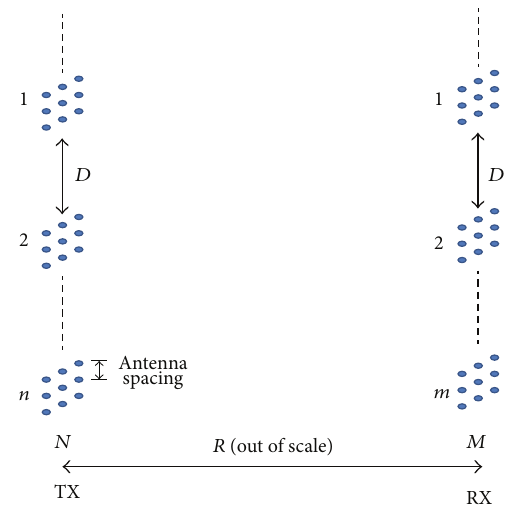
Figure 1: N × M MIMO system geometry. Each MIMO node is a URA.